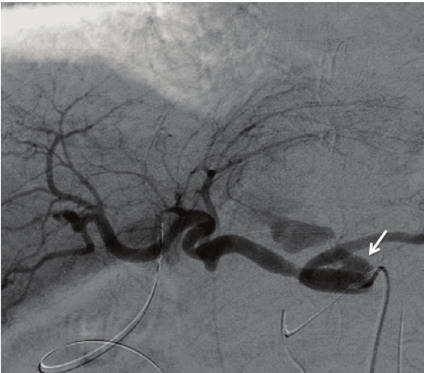
Figure 1: Angiography shows bleeding from celiac artery (arrow).